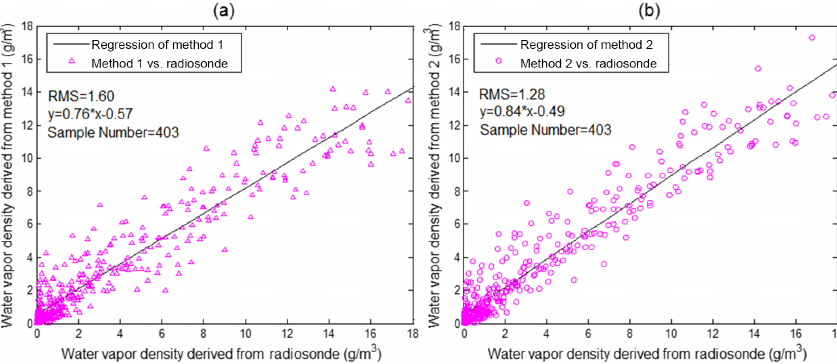
Figure 15. Scatter plot of water vapor density between different methods and radiosonde at date 12:00UTC once per day from 1 to 31 May